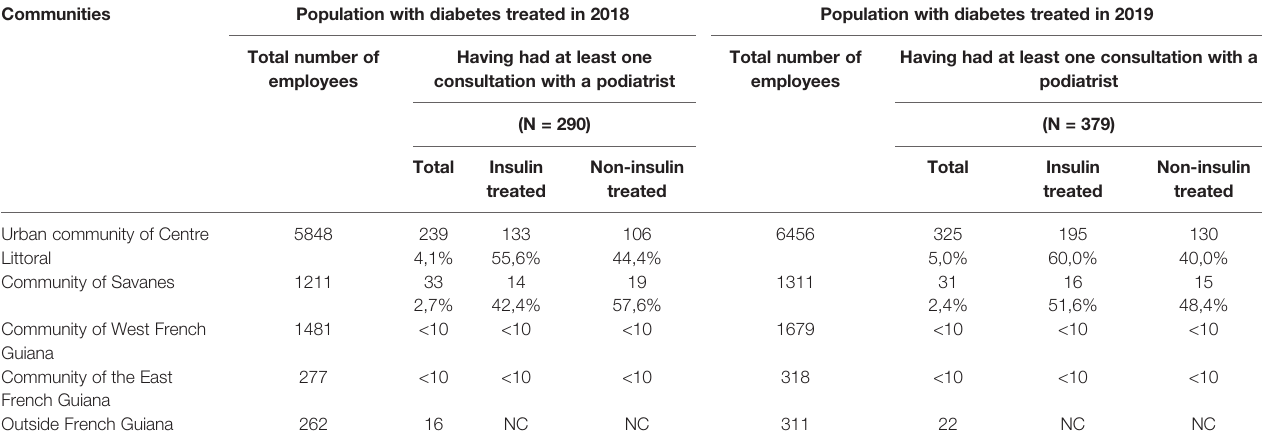
TABLE 3 | Distribution of podiatrist consultations according to the regions of the territory and according to the insulin therapy of patients with diabetes.